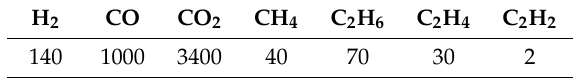
Table 1. The 95% typical concentration values (ppm) in bushings proposed in the IEC 60599 Standard. H 2